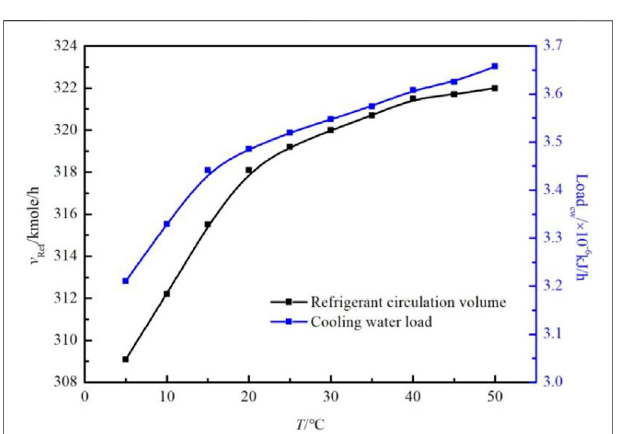
FIGURE 8 | In fl uence of natural gas pressure on freezing mixture circulation rate and cooling water load of the